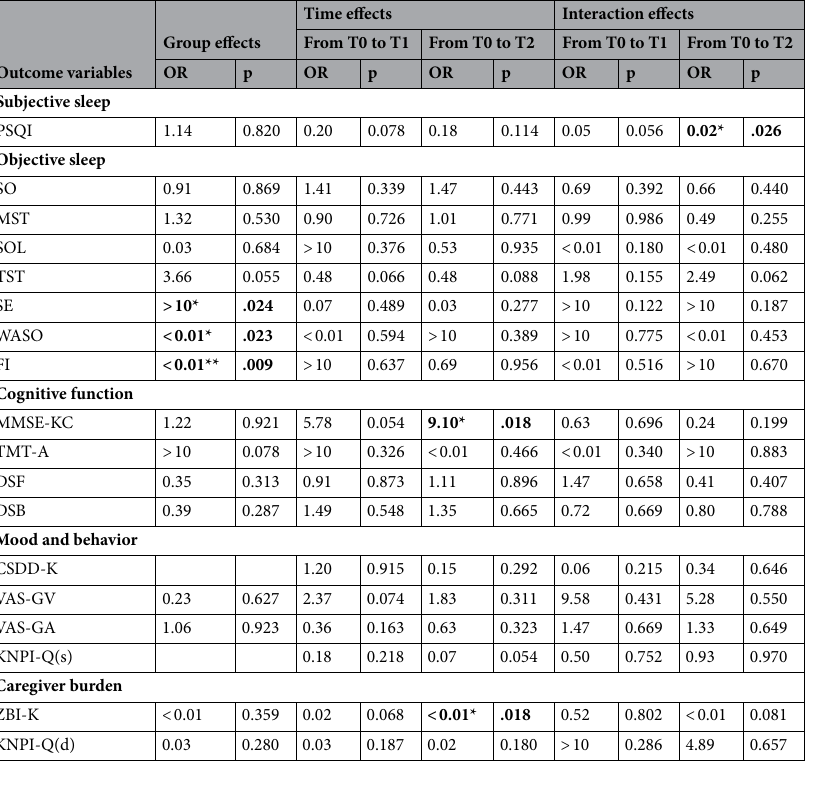
Table 4. GEE models for the changes of outcome variables before and after the timed light treatments. T0 = baseline, T1 = immediate post-treatment, T2 = 4 weeks after the end of the 2 weeks of light treatment. [T0] as reference for the Time effects; [CG] and [T0] as reference for the Interaction effects. GEE generalized estimating equations, OR odd ratio, TG treatment group, CG control group, PSQI Pittsburgh Sleep Quality Index, SO sleep onset, MST Mid-sleep time, SOL Sleep onset latency, TST Total sleep time, SE Sleep efficiency, WASO Wake after sleep onset, FI Fragmentation index, MMSE-KC MMSE in the Korean version of CERAD Packet, TMT-A Trail making test-A, DSF Digit span test forward, DSB Digit span test backward, CSDD-K Korean version of the Cornell Scale for Depression in Dementia, VAS-GV Visual analogue scale for global vigor, VAS-GA Visual analogue scale for global affect, KNPI-Q(s) Korean Version of the Neuropsychiatric Inventory Questionnaire (severity), ZBI-K Korean version of Zarit Burden Interview, KNPI-Q(d) Korean Version of the Neuropsychiatric Inventory Questionnaire (distress). *p < 0.05, **p <